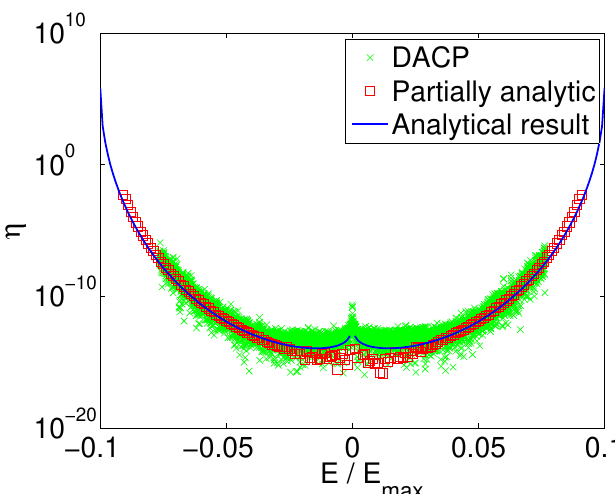
Figure 9: Comparison of relative error distributions η ( E ) obtained via the DACP method (green crosses), simulation (partially analytical results) of DACP (red squares) and analytical prediction from Eq. (E.3) (blue curve) for the initial state | ψ 〉 = β (cid:80) | E 〉 . The results of DACP are the same as in Figure 3(b), except that c E i i i the range is rescaled from a = 0.16 to a = 0.1. Note that in Eq. (E.3), the rela- tive error η ( E ) is proportional to c − 2 , especially for those eigenvalues far away from i E =